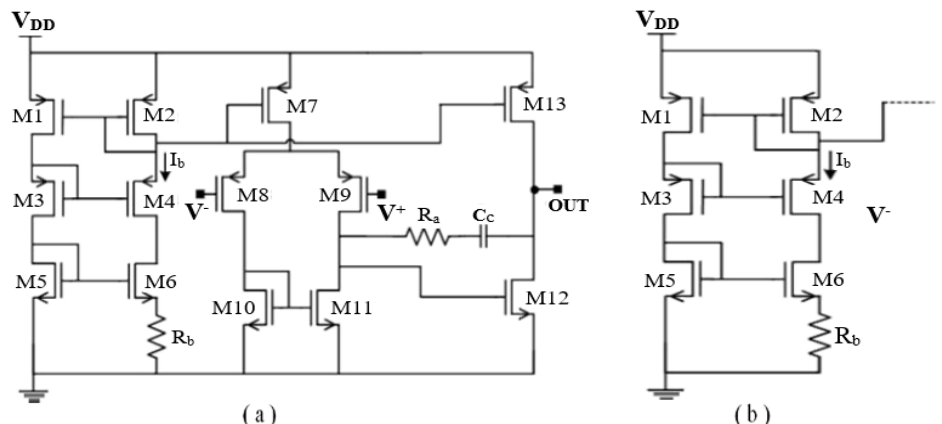
Figure 2. Proposed OTA circuit: ( a ) two–stage CMOS op–amp configuration; ( b ) configuration used to bias two–stage op–amp.